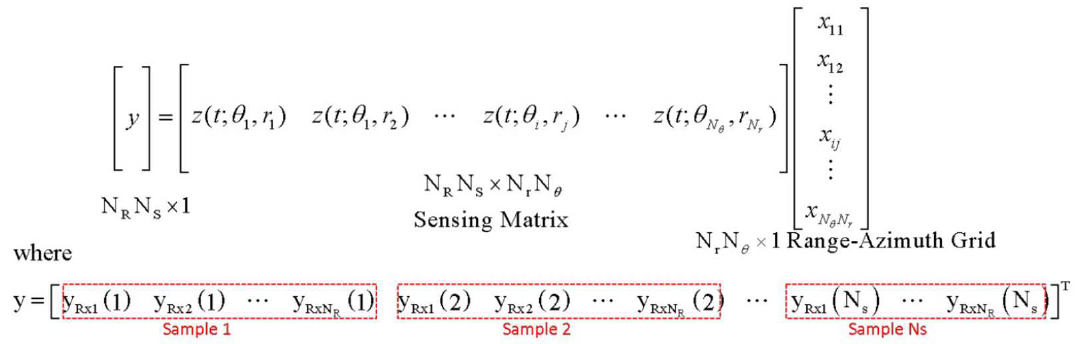
Figure 1. Multiple-input multiple-output (MIMO) compressive sensing radar